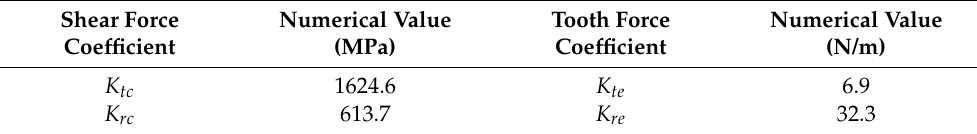
Table 3. The milling force coefficient tables.